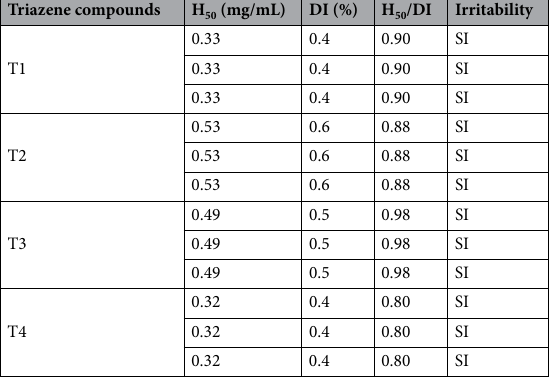
Table 8. Mucous membrane irritation potential of triazene against sheep erythrocytes. SI Severe irritant, DI Denaturation index, H 50 Hemolysis 50%.